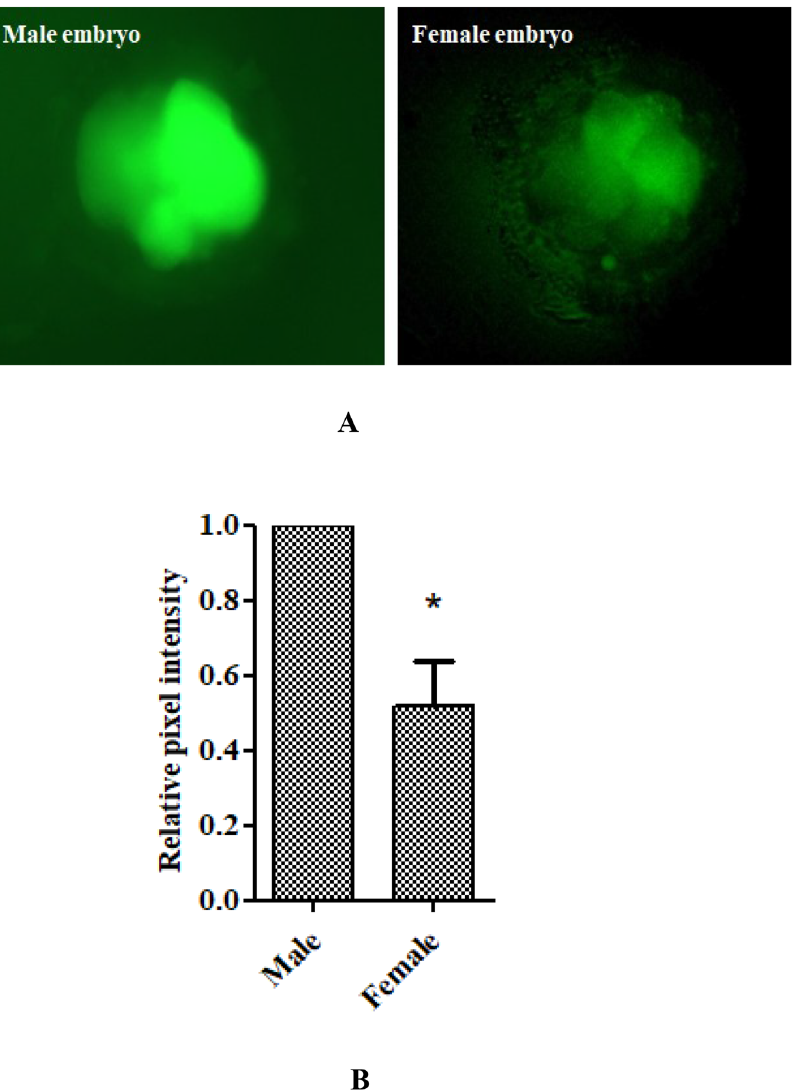
Figure 5. Sex-specific differences in intracellular embryonic ROS level. *Significant difference between male and female at P < 0.05. ( A ) Embryos stained with 2 ′ ,7 ′ -dichlorodihydrofluorescein diacetate. ( B ) Fluorescence intensities (mean ± SEM) quantified based on grey pixel